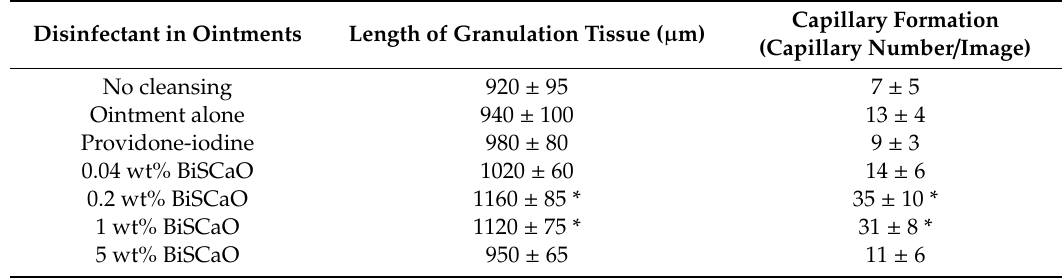
Table 1. Histological examination of the length of granulation tissue and capillary formation.